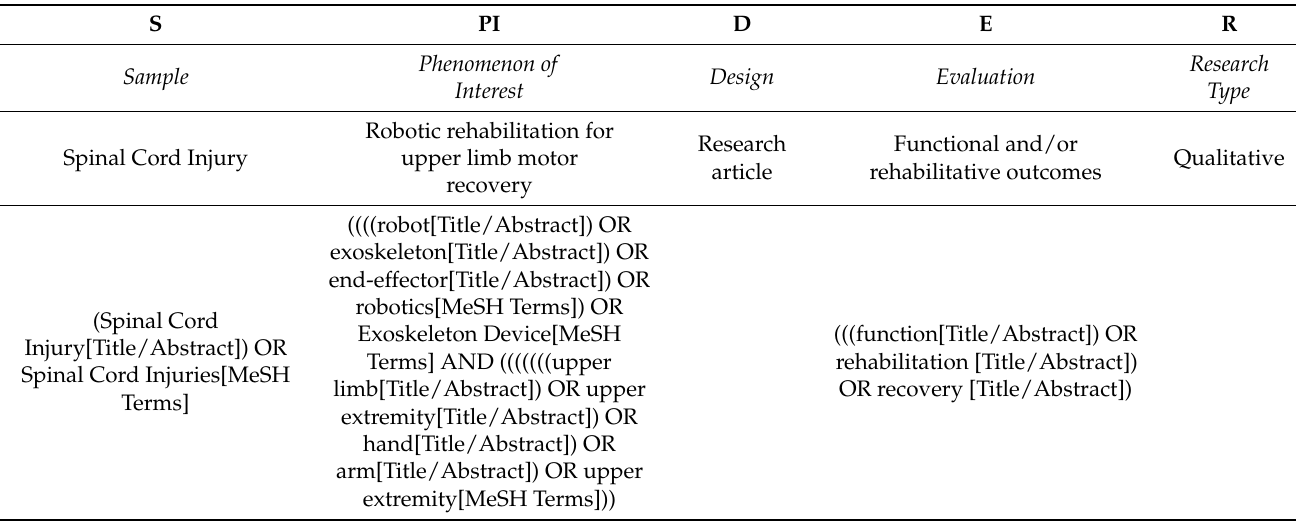
Table 1. Spider tool search